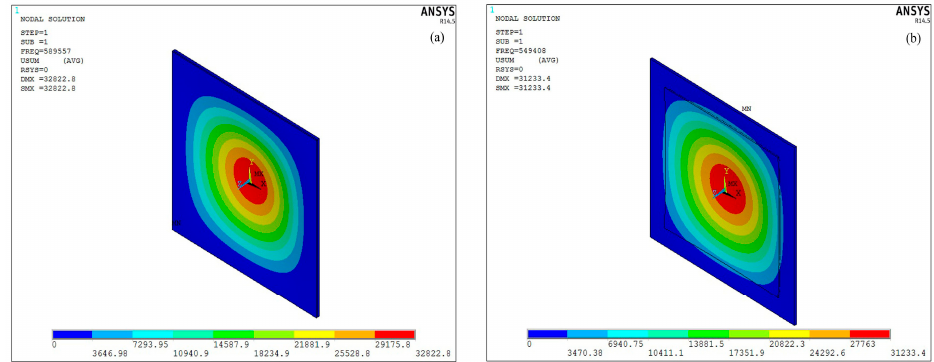
Figure 3. The displacement distributes of the piezoelectric composite diaphragm at first resonance mode ( a ) for whole or centric electrode and ( b ) for partially-etching ZnO film.